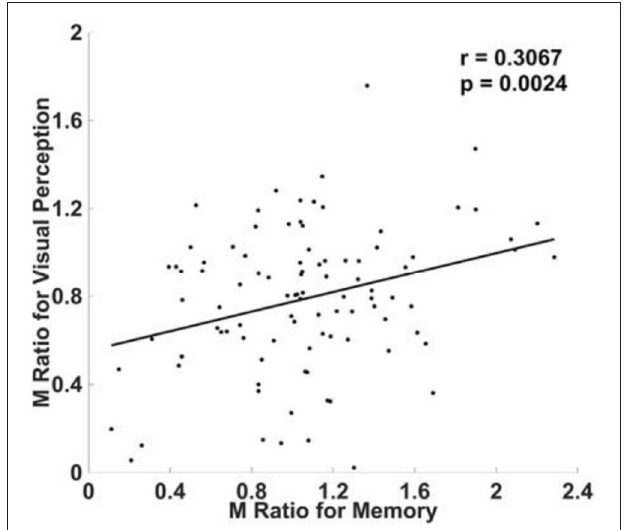
FIGURE 2 | Correlation between visual and memory metacognitive efficiency when when both tasks involved 2AFC. As in McCurdy et al. (2013), we found a significant positive correlation across subjects, between visual and memory metacognitive efficiency when both tasks involved 2AFC rather than YN judgments. Metacognitive efficiency was quantified using M Ratio, a detection theoretic measure of metacognitive efficiency that accounts for fluctuations in task performance (see section Materials and Methods).